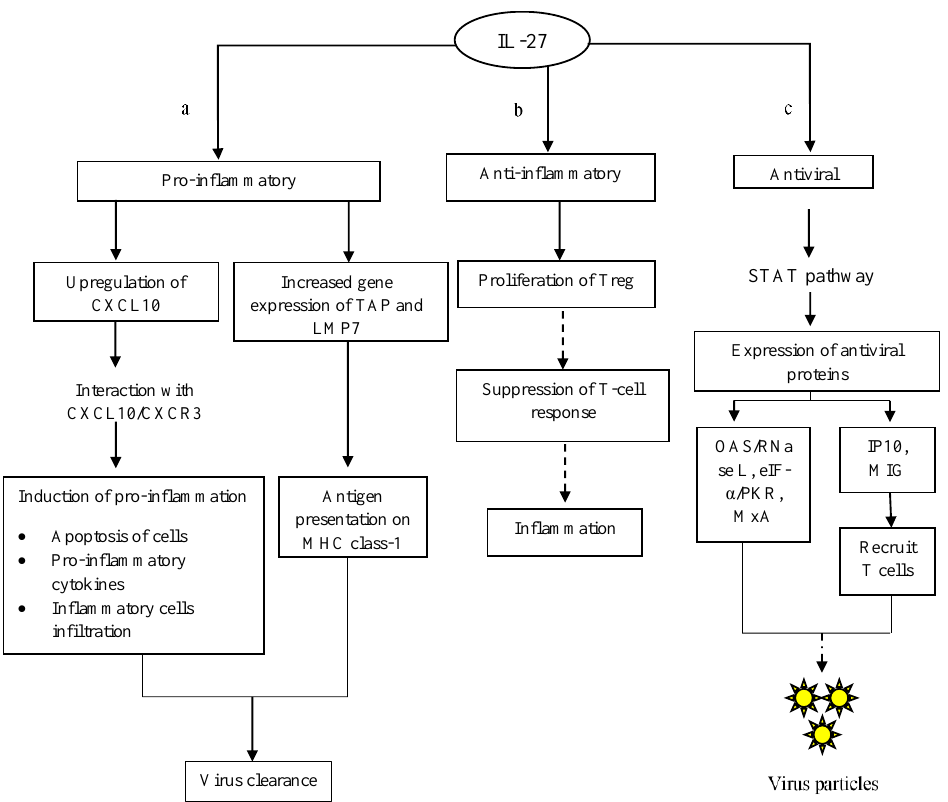
Figure 5. IL-27-mediated antiviral response in infected cells. ( a ) IL-27 triggers the production of effector mediators and chemokines to promote inflammation. These mediators enhance the host immune response in its targeting of virus infections, for example antigen presentation, cell apoptosis, synthesis of pro-inflammatory cytokines and infiltration of immune cells. Those pro-inflammatory reactions are responsible for virus clearance. ( b ) In order to control the occurrence of pro-inflammations in infected cells, IL-27 promotes the formation of Treg cells that execute anti-inflammatory responses in the host. Treg controls T-cell-mediated inflammation in order to prevent undesired immune-mediated complications. ( c ) Upon binding to receptors, IL-27 activates STAT signalling pathways. The activation of STAT signalling results in the transcription and translation of antiviral products that help target virus replication. The dashed-line arrows indicate inhibitory actions on cellular inflammation and the synthesis of new virus progeny.